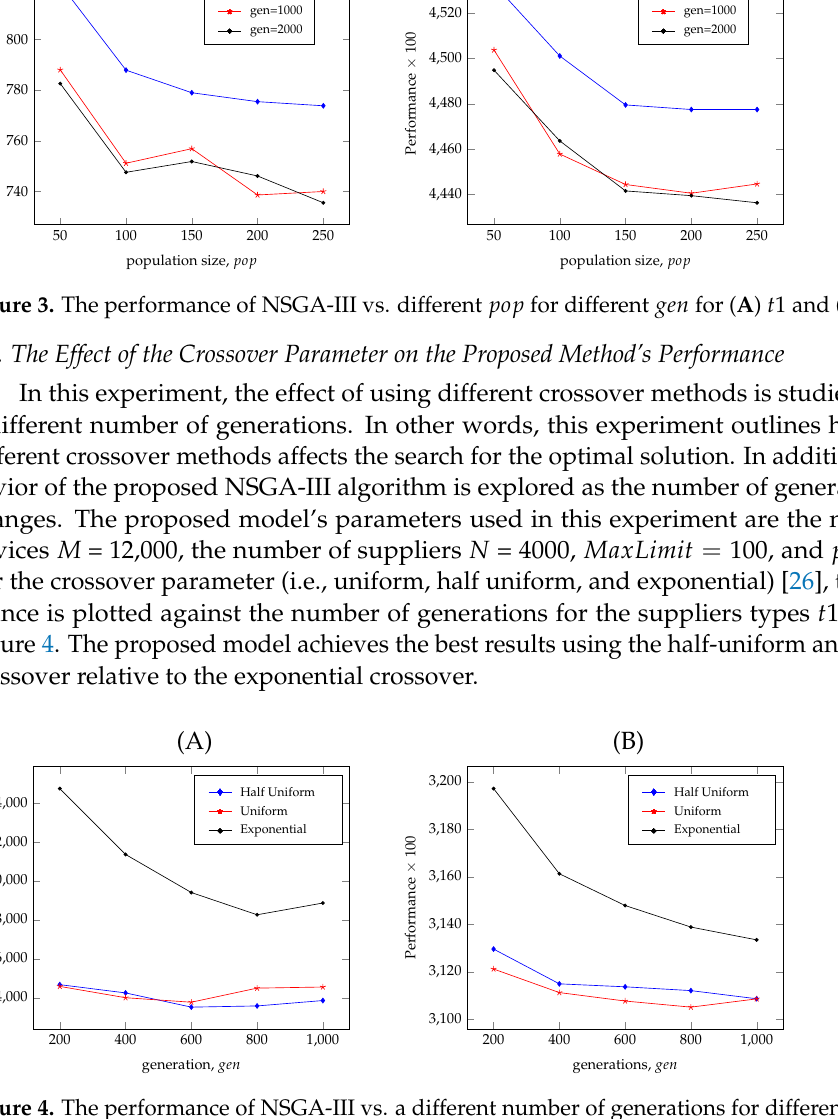
Figure 4. The performance of NSGA-III vs. a different number of generations for different crossover parameters for ( A ) t1 and ( B )